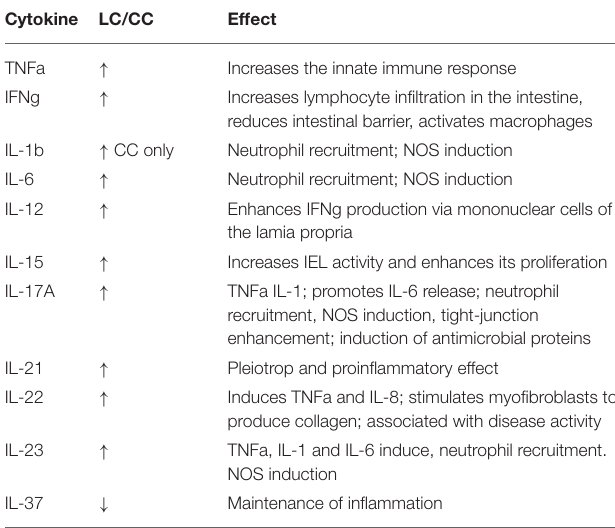
TABLE 1 | Expression of citokines in Microscopic